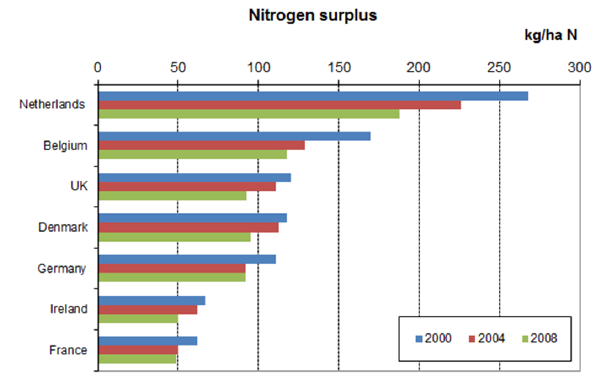
Figure 1. Gross annual nitrogen balance between 2000 and 2008 (Eurostat, 2011). 5 Fig. 1. Gross annual nitrogen balance between 2000 and 2008 (Eu- 6 rostat, 2011).